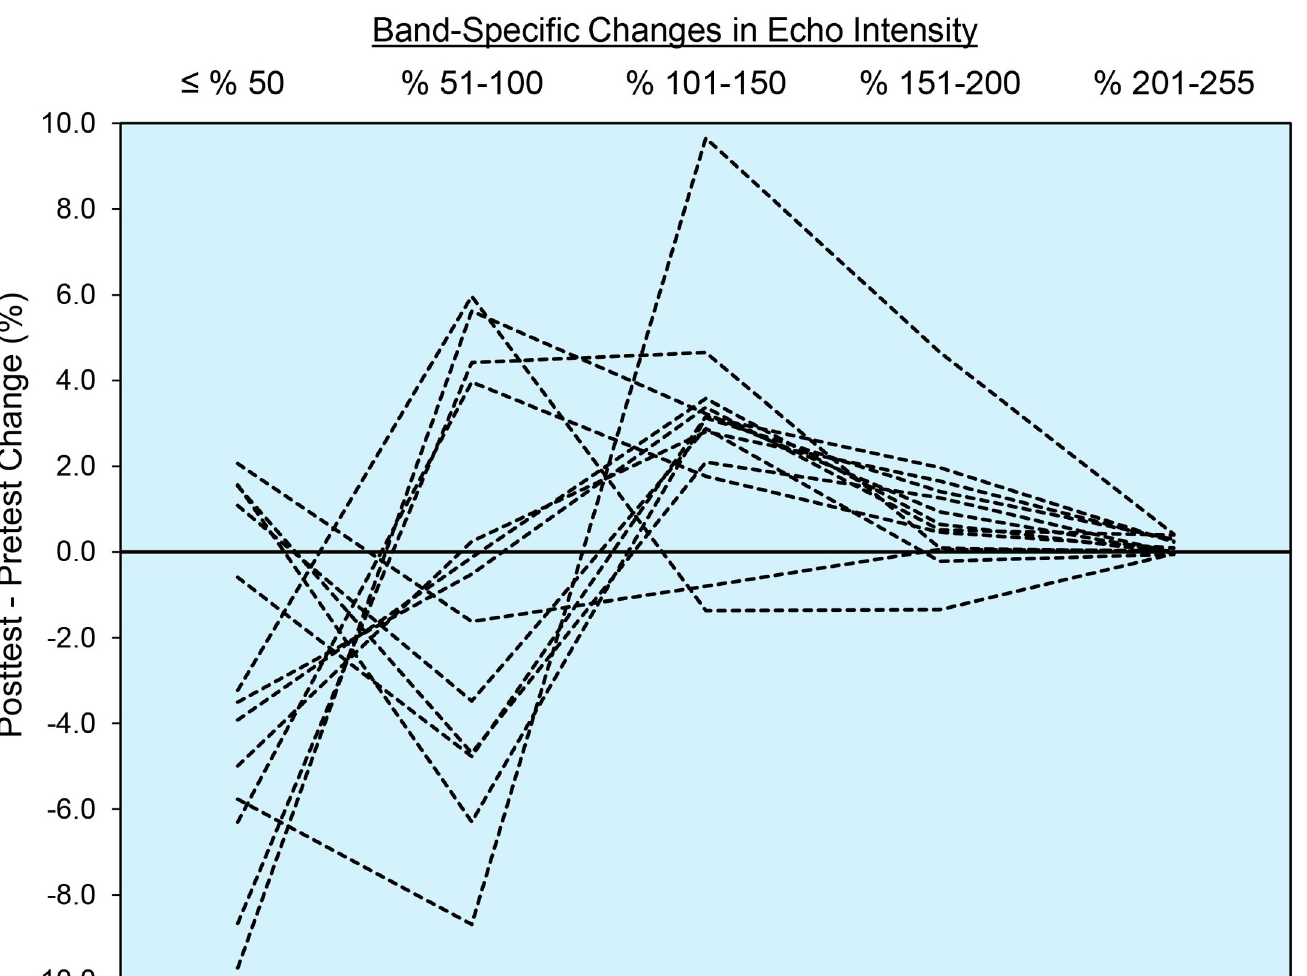
Fig 3. Individual participant change score values across each of the 50 A.U.